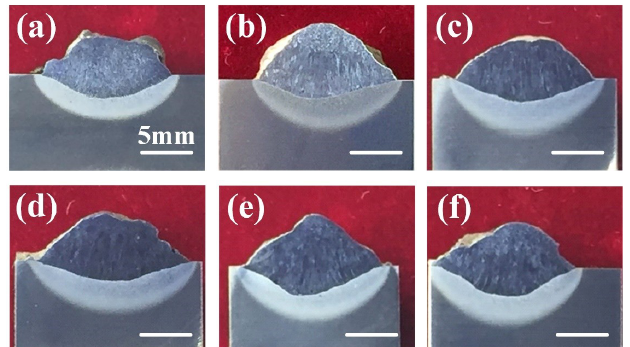
Figure 6. Cross-sections of welded joints obtained at different conditions: ( a ) without ultrasonic; ( b – f ) ultrasonic output power was 20%, 40%, 60%, 80%, and 100% of the maximum power (1200 W), respectively.